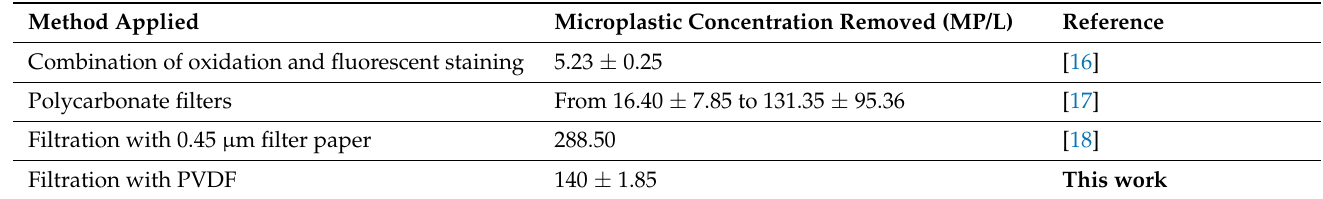
Table 1. Mass (g) and concentration (MP/L) of microplastics filtered with a PVDF membrane from 400 mL water samples.